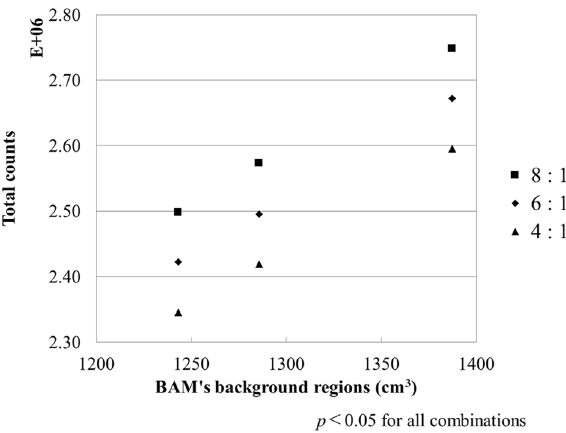
Figure 5. Relationship between detected total counts and the volume of BAM background regions. Cs decreased linearly with the increasing volume of BAM background regions.